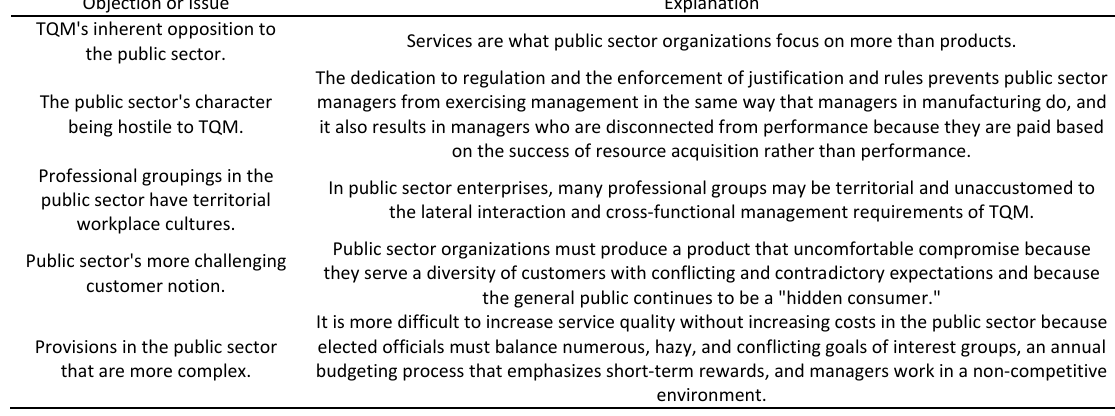
Table 4: The public sector's adoption of TQM: five common concerns and issues (Morgan and Murgatroyd, 1994)